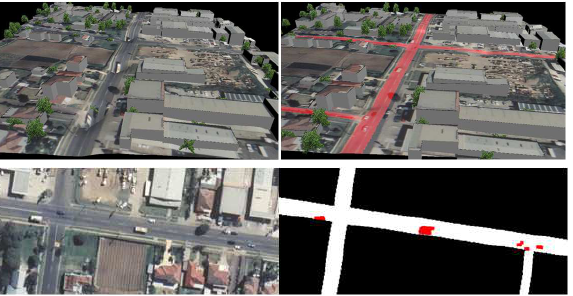
Figure 6: Top left: part of the model view for the data-set Fair- field ; model was generated from the depth map of Fig.3, right. Outliers caused by moving object are clearly visible. Right: sim- ilar view of the improved model; pixel belonging to street have been identified by means of GIS data and are marked in pink. Bottom left and right: Deviations between the original and the corrected DSM provide alarms about moving objects. After ap- plying some morphological operations, several moving vehicles have been